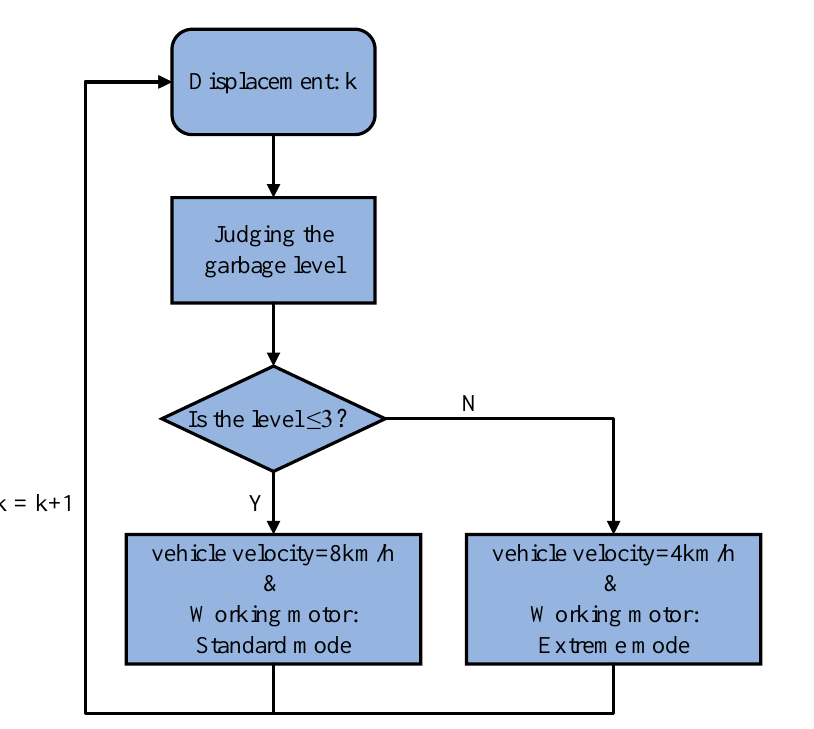
Figure 24. Logic of the rule-based EMS.